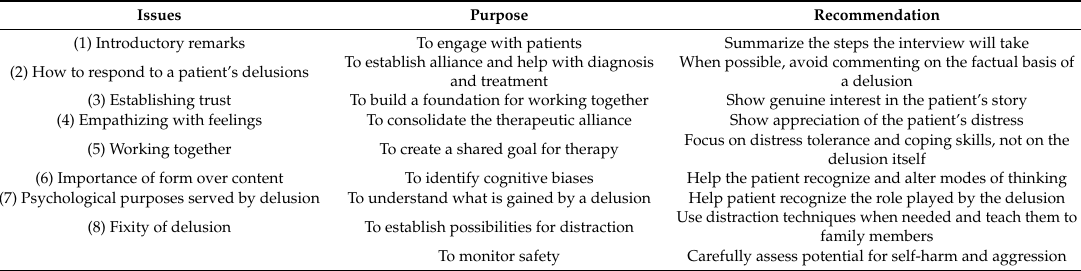
Table 1. Therapeutic approach to patients su ff ering from